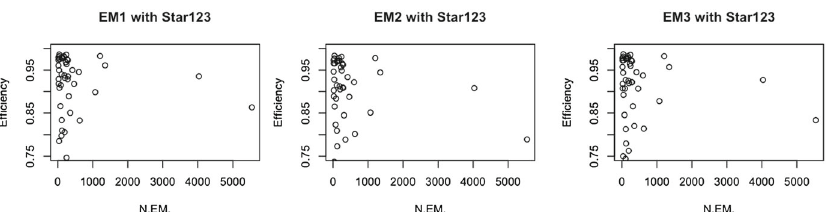
Fig. 3 Relationship between efficiency and number of